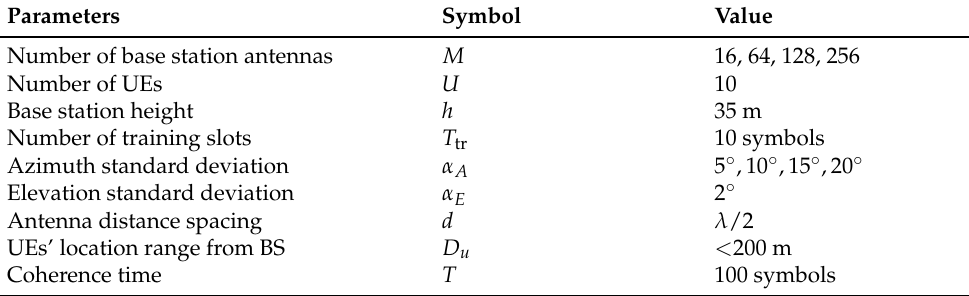
Table 1. Simulation